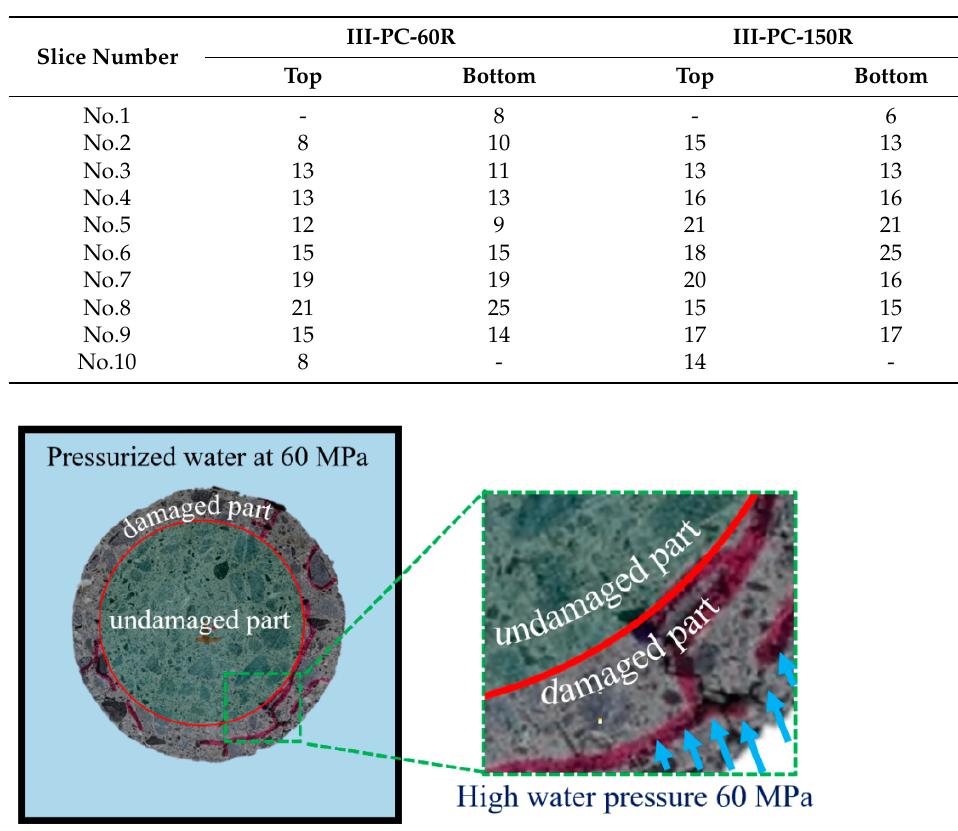
Figure 12. Internal cracking state for typical slices ranging from No. 4 to No. 9 of series III after repeated high-water-pressure cycles. Table 4. Crack penetration depth measurements.